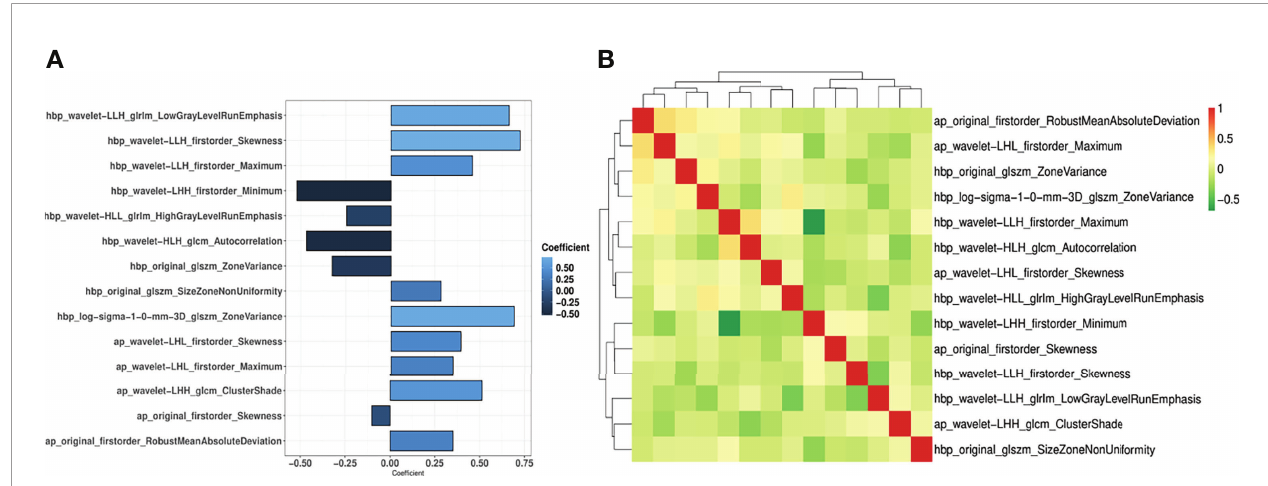
FIGURE 4 | Coef fi cient of the 14 imaging features (A) and the correlation coef fi cient heatmap (B) in the